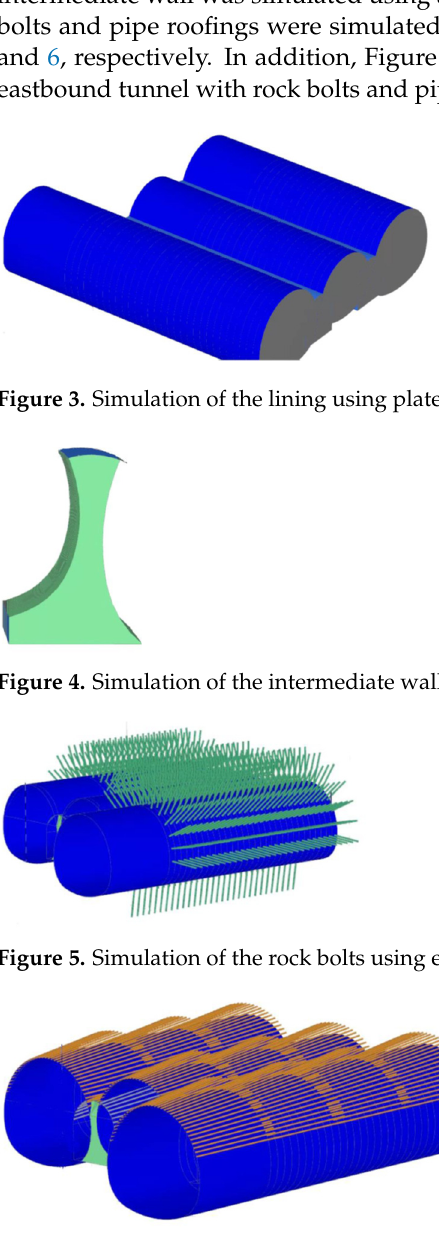
Figure 6. Simulation of the pipe roofings using embedded beams.